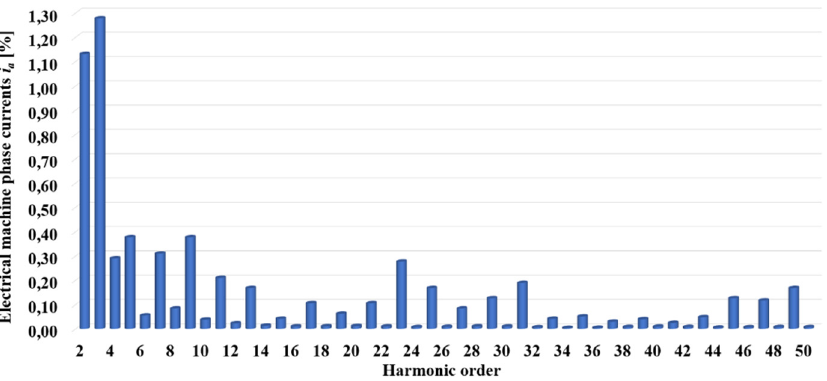
Figure 23. Harmonic spectrum of the electrical machine phase currents i a .